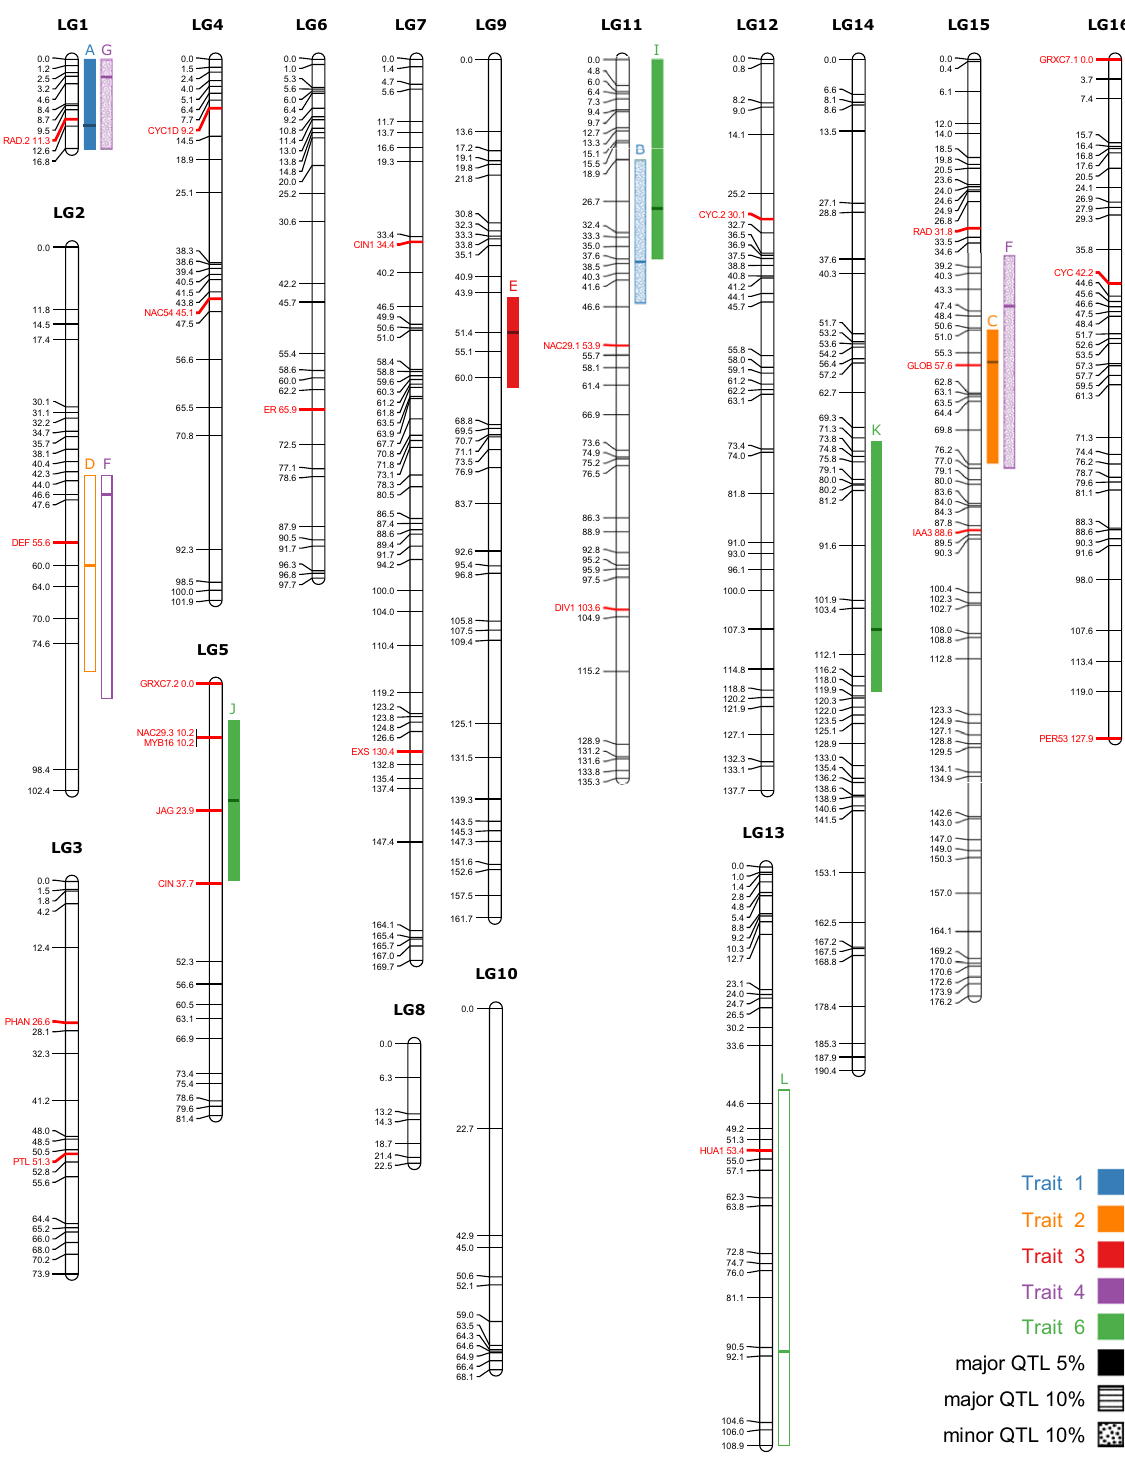
Fig 5. Linkage map with 12 QTLs. The linkage groups (LG) were given the same names as in Alexandre et al. [63] and QTLs are represented by coloured bars to the right of their designated linkage groups, with letters on top referring to Table 2. The patterns in QTLs bars represent different significance thresholds indicated in the legend, and the horizontal bar represents the peak location (see Table 2). The 24 candidate genes are in red, including CYC and RAD from Alexandre et al. [63]. Positions of markers are in cM. Minor QTLs are those that were detected after including the primary QTL as a covariate in the